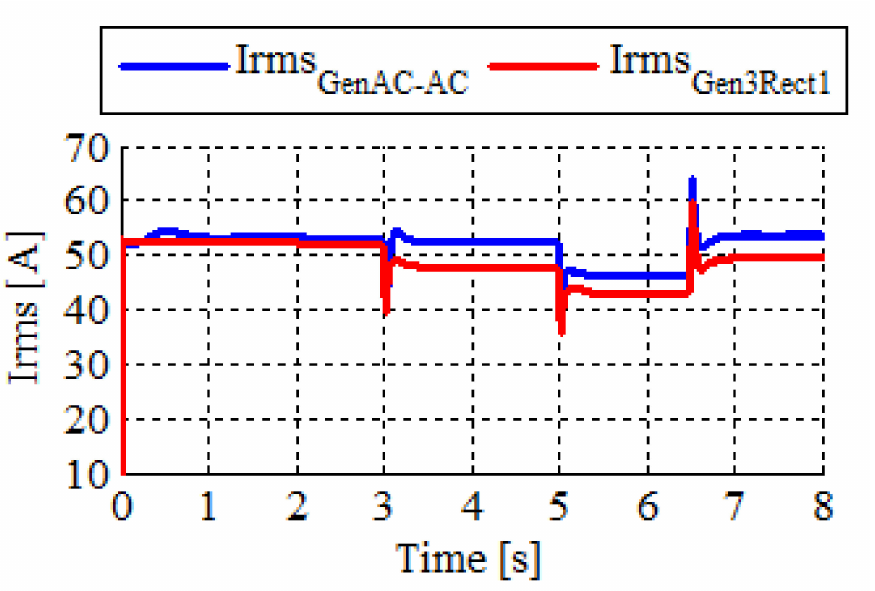
Figure 13. Effective current delivery by the